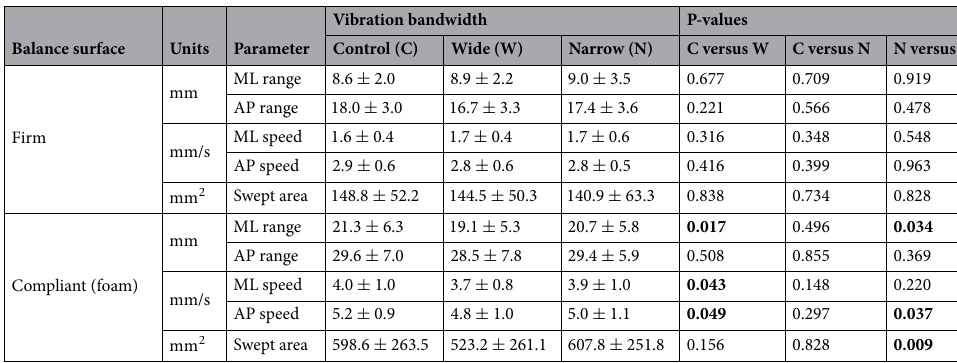
Table 2. Marker sway parameters (mean ± SD) for firm and compliant surface balance trials with different mechanical noise bandwidths